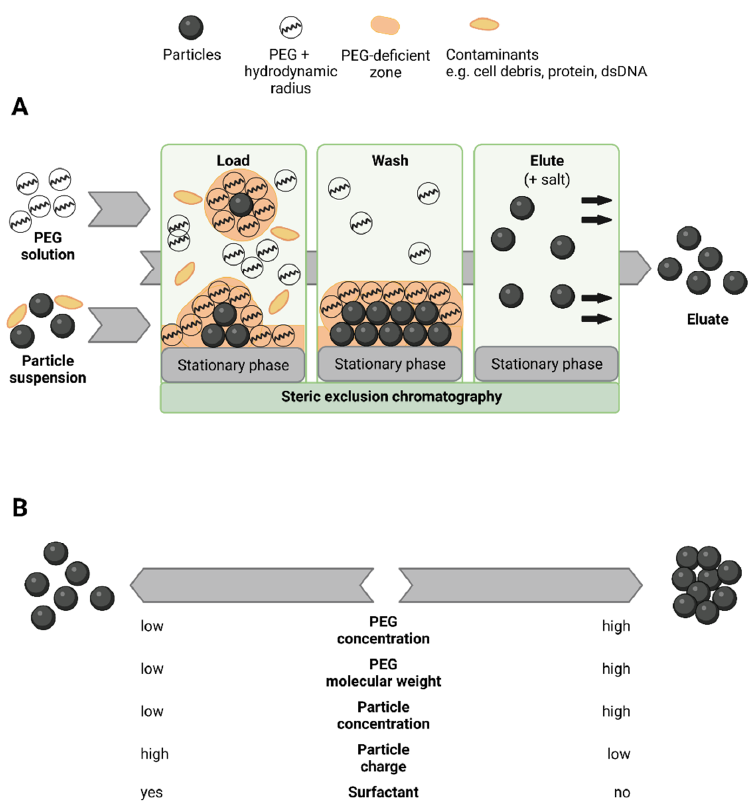
Figure 1. Theory of working principle and influencing factors of the steric exclusion chromatography (SXC). The SXC is a chromatographic method based on the core-concepts of polyethylene glycol (PEG) precipitation: ( A ) represents the steps of the method’s application as a chromatographic purification technique. ( B ) depicts a selection of parameters influencing the target aggregation and accretion behavior, which were found to be critical for the SXC. Created with bioRender.com.